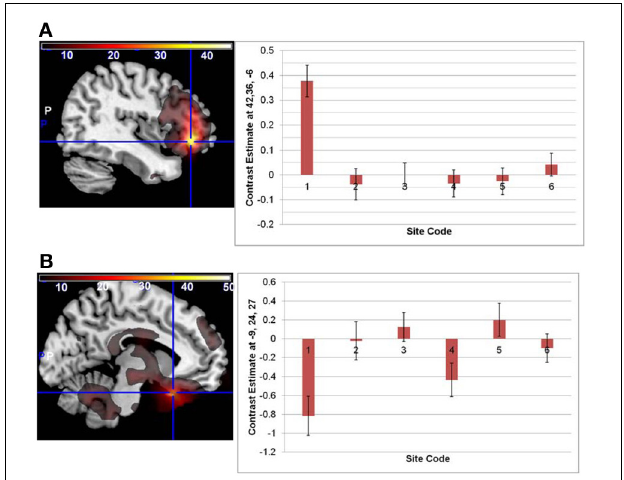
FIGURE 1 | The effects of motion and physiological signal regression on ALFF values: The regression step strongly increased ALFF values in more internal gray matter areas (shown in red to yellow, showing t -values from 2.5 to 20), and more weakly decreased ALFF values around the brain edges and thalamus (shown in blue, with t -values from 2.5 to 4.5). All values from the paired t -test are thresholded at t > 2 . 5, FDR corrected p < 0 . 05. All images are in neurological convention (left is on the left) with the slice location on the z-axis shown.